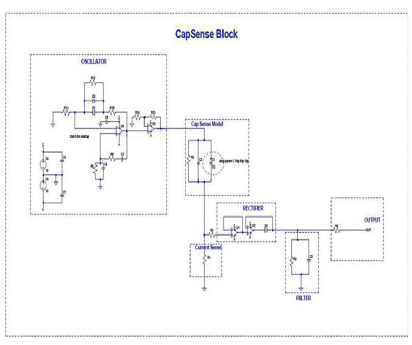
Figure 7: Circuit diagram of CapSense block. Table 1. Materials with dielectric steady somewhere in the range of 2.0 and 8.0 are appropriate for capacitive detecting applications. The conductive material cannot be fit as an overlay substrate due to its impedance. Consequently, we should not utilize paints that contain metal particles in the